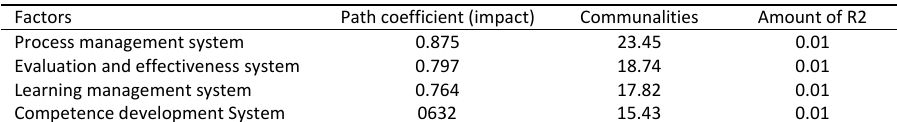
Table 3: Results of regression test Table 3. Results of regression